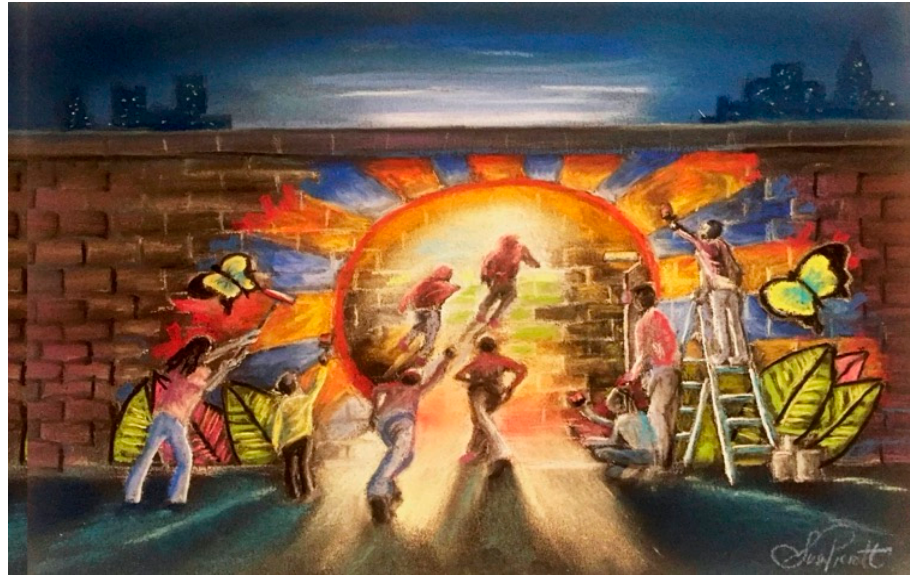
Figure 6. Imagining a better future. Creativity can inspire hope and optimism to create new possibilities, opportunities and the power of shared purpose. Art by S.L.P.